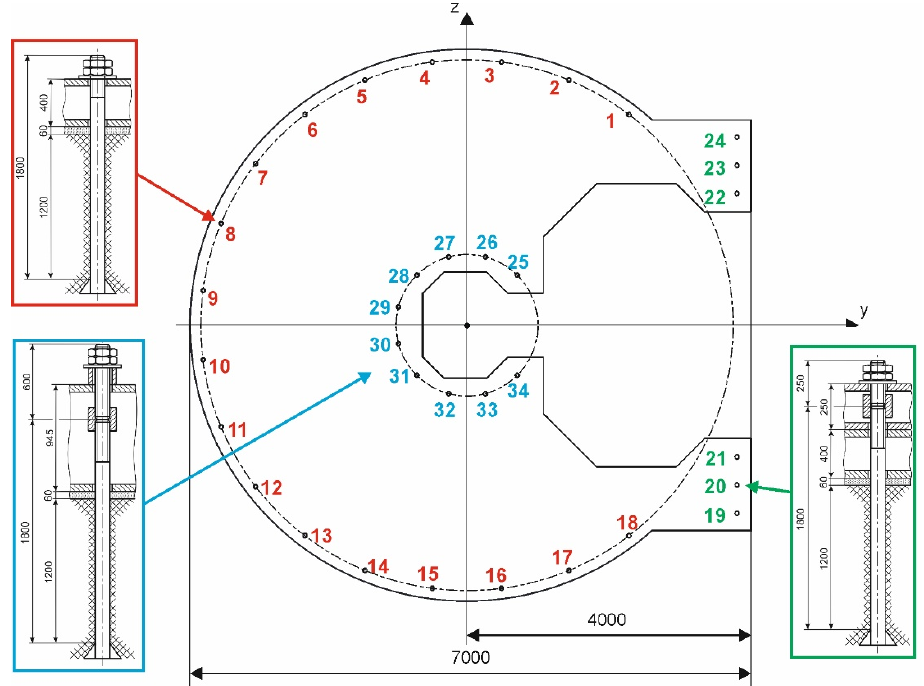
Figure 2. Layout of anchor bolts and their basic dimensions.